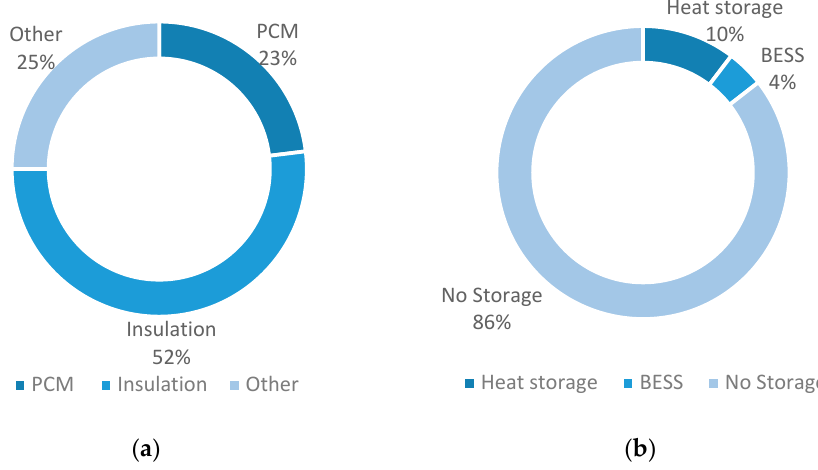
Figure 8. Percentage of studies using passive technologies ( a ) and share of used storages ( b ).